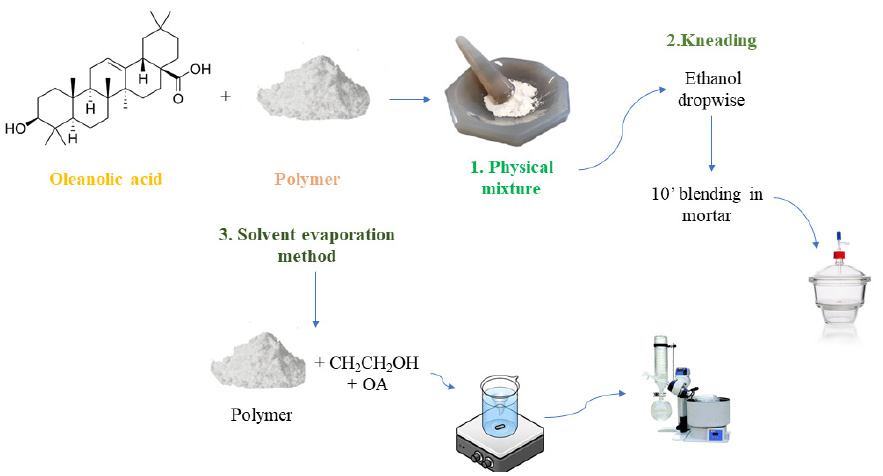
Figure 8. Schematic representation of preparation of the solid dispersions using physical mixture, kneading, and the solvent evaporation method.